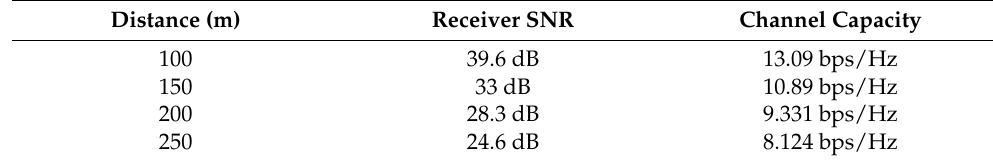
Figure 7. For 20 × 1, θ tilt = θ LoS , CDF of channel capacity at D = 100 m, 150 m, 200 m, 250 m. Table 4. For 20 × 1, θ tilt = θ LoS , simulation results at D = 100 m, 150 m, 200 m, 250